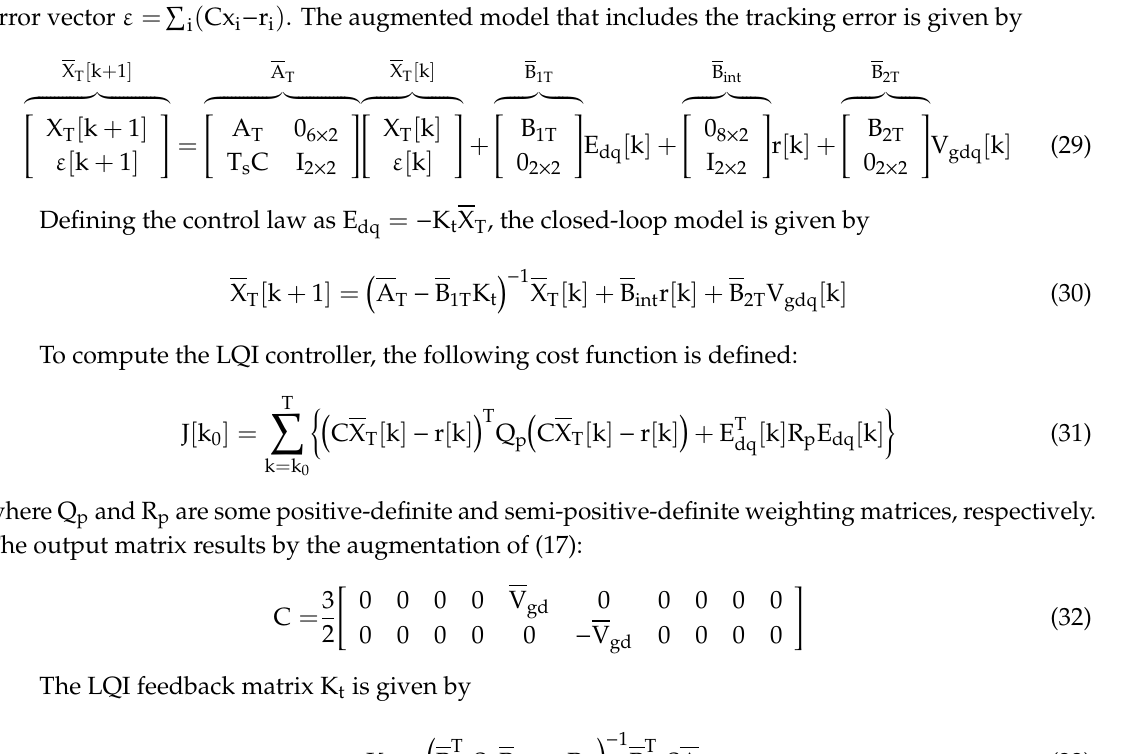
Figure 17. Control scheme for the grid-connected LQI power controller.